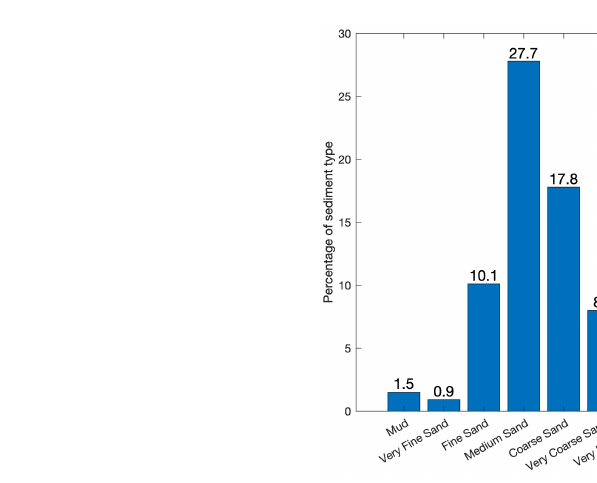
FIGURE 2 Percentage of sediment type across all seabed